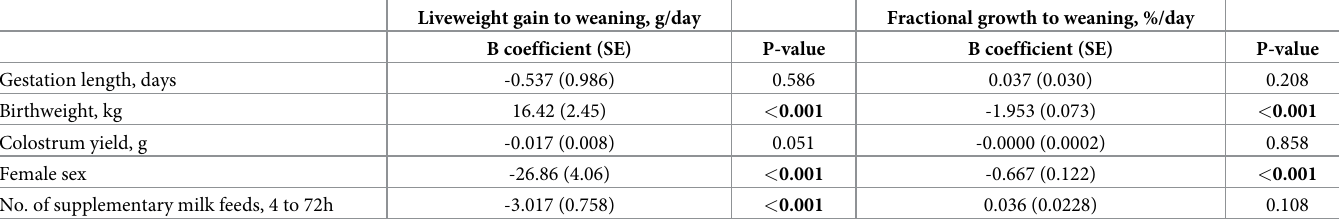
Table 7. Impact of gestation length, birthweight, sex and supplementary milk feeding in the neonatal period on growth to weaning at 77days of age in singleton lambs (n = 341). Liveweight gain to weaning, g/day Fractional growth to weaning, %/day Β coefficient (SE) P-value Β coefficient (SE) P-value -1.953